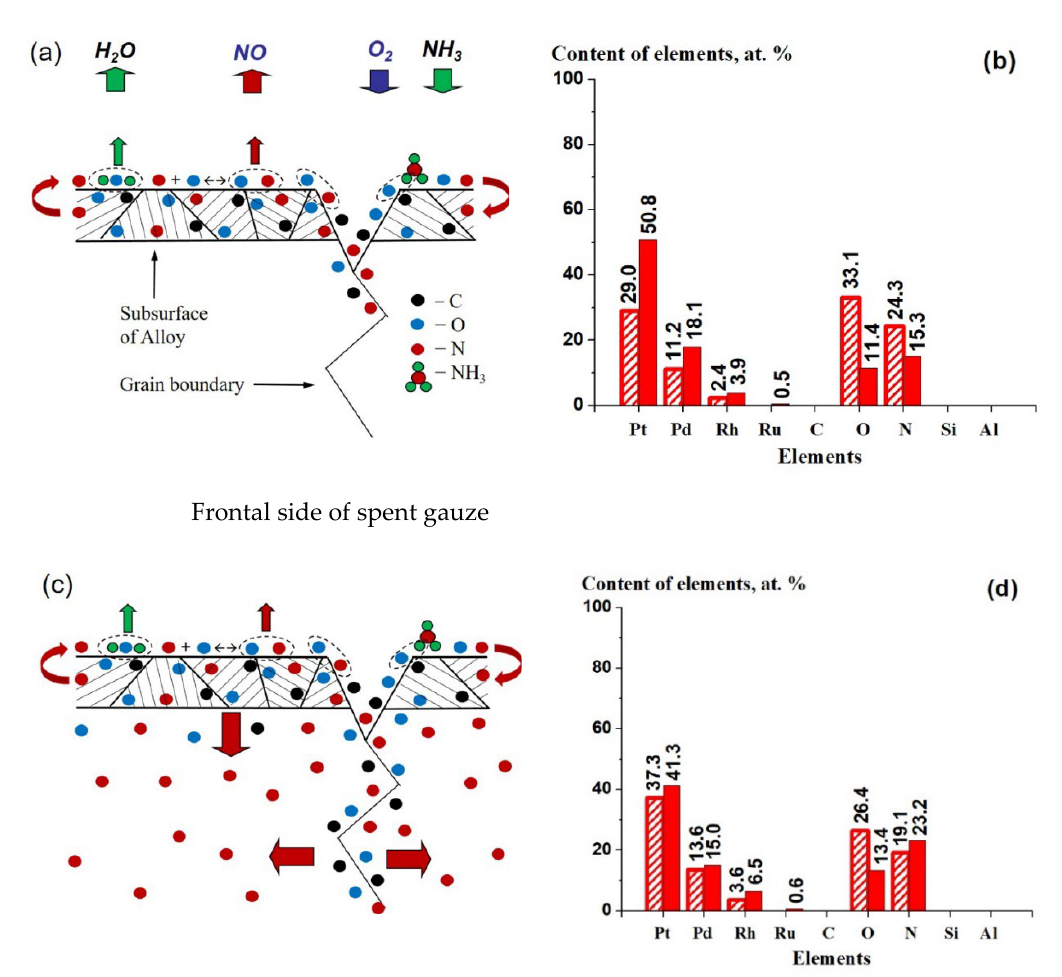
(shaded bars) and EDS (solid bars) data for the back (b) and frontal (d) sides of the gauze after NH 3 oxidation at 1133 K.